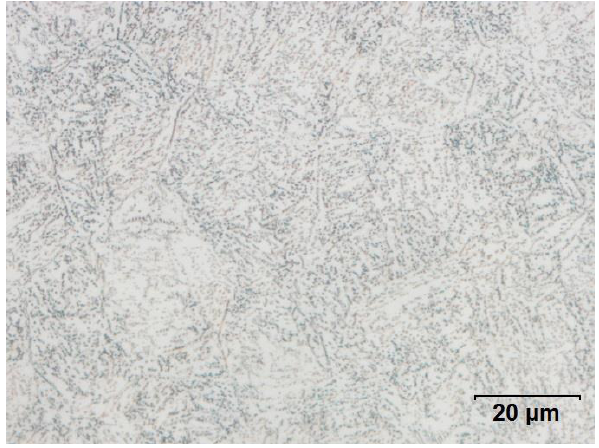
Figure 1. Homogeneous initial microstructure of X30Cr13 (V2A etchant). A ferritic matrix with chromium carbides is visible.